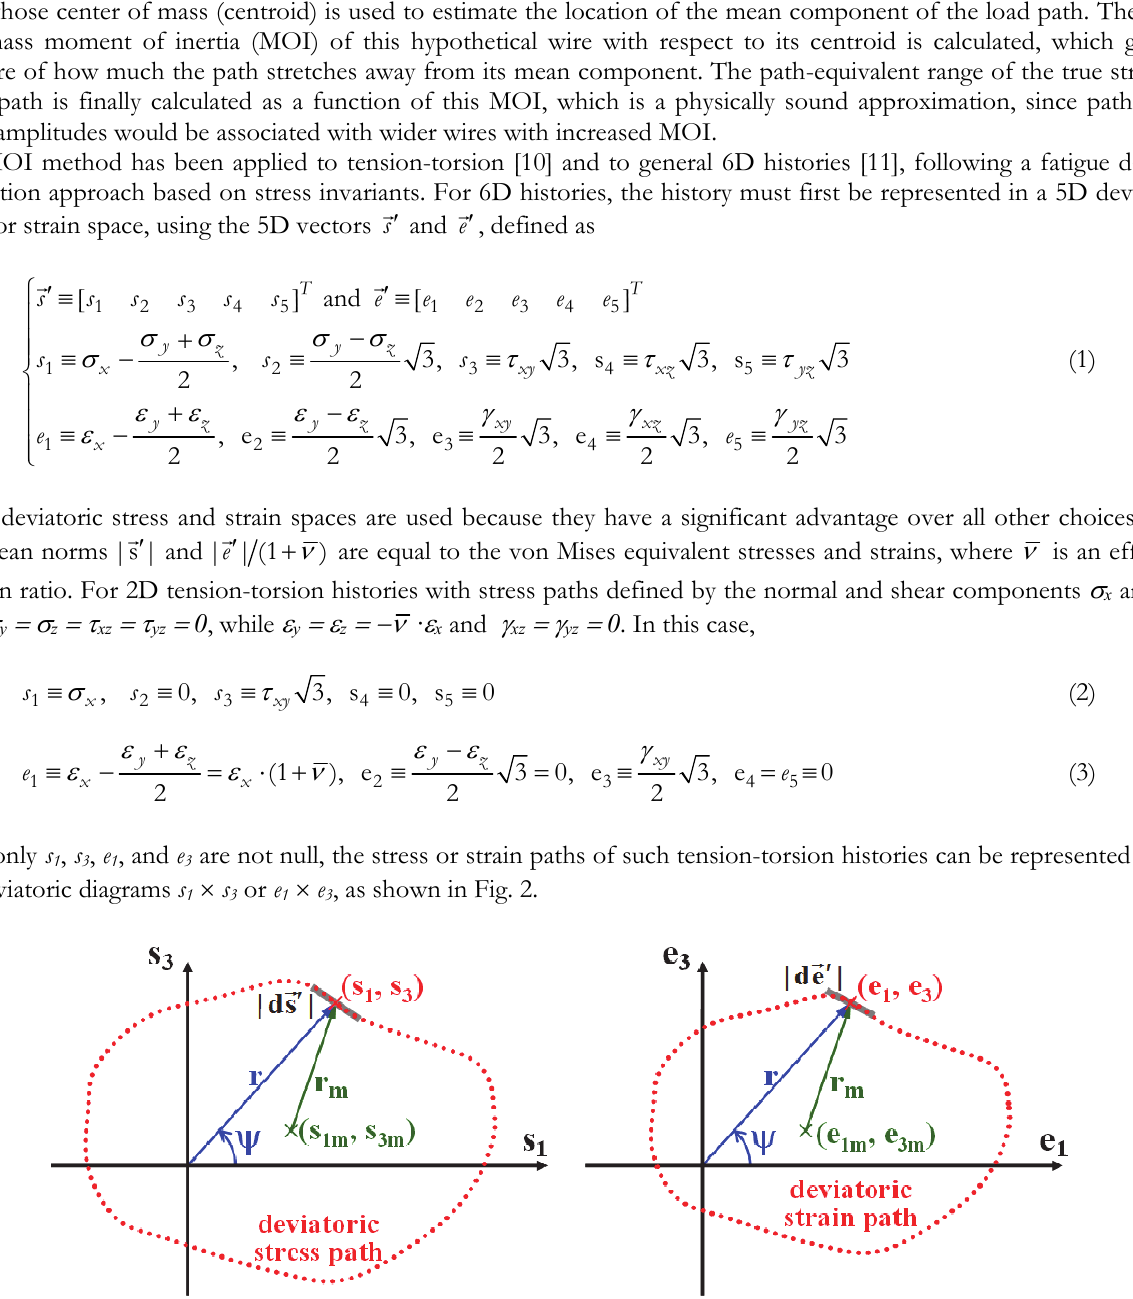
Figure 2: Stress path of a 2D tension-torsion load history in the deviatoric s 1  s 3 diagram (left) and its corresponding strain path in the e 1  e 3 diagram (right), both assumed as homogeneous wires with unit